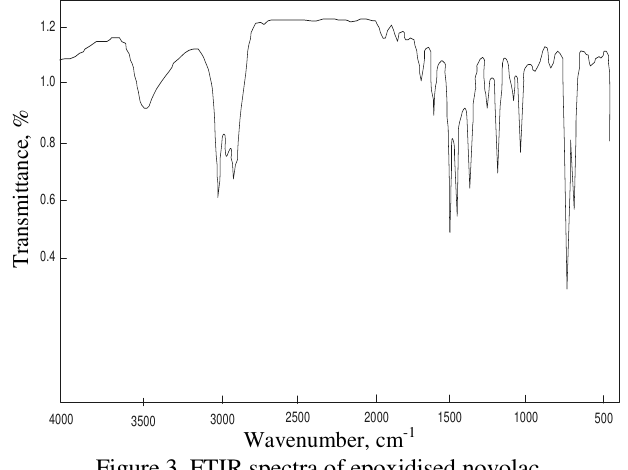
Figure 3. FTIR spectra of epoxidised novolac.